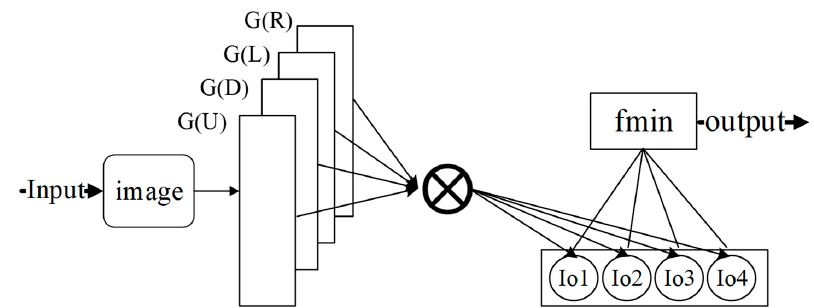
Figure 4. The four triangular Gaussian subtemplates.